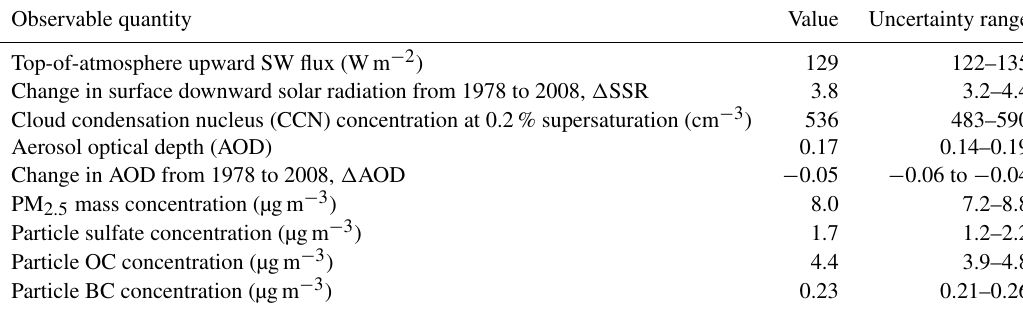
Table 2. Observed quantities and corresponding uncertainty ranges used for the constraints applied over Europe. Values are a European July mean, synthetically generated from the model output of a selected PPE